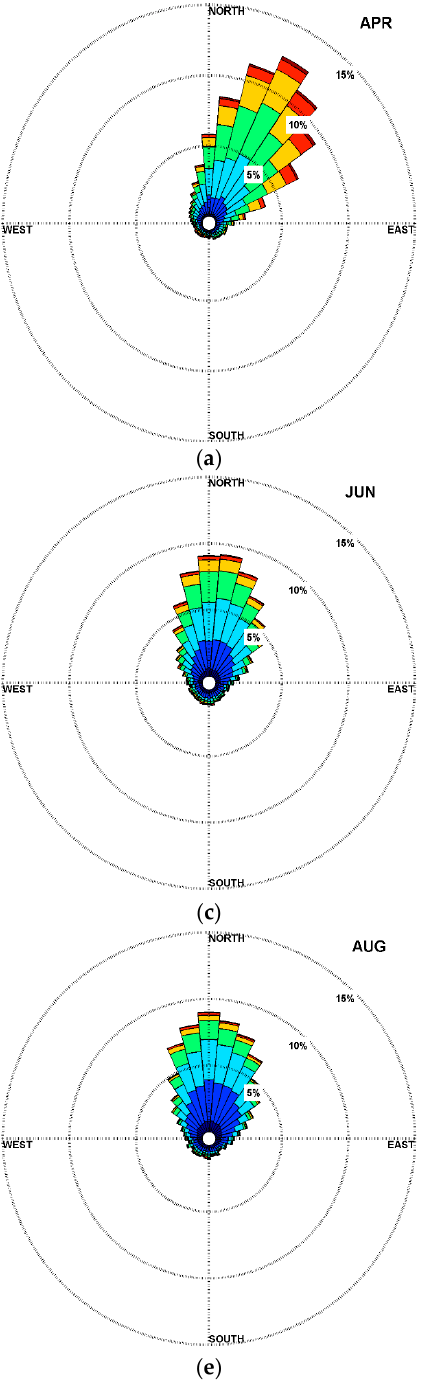
Figure 8. Rose diagrams of thunderstorm movement distributions for ( a )–( f ): April through September.